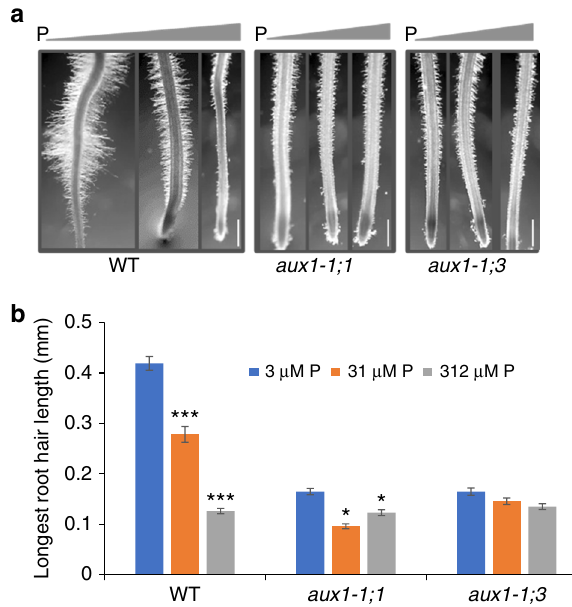
Fig. 3 OsAUX1 promotes root hair growth at low external P levels. a 9-day- old WT, os aux1-1;1 and osaux1-1;3 seedlings were grown for 6 days in hydroponics at three different P concentrations. Scale bar 1 mm. b Quantitation of RH length in WT, os aux1-1;1 and osaux1-1;3 mutants reveal low P. Each bar represents the average length of 30 – 60 fully elongated RH on >10 nodal roots. *, **, and *** indicate signi fi cant difference p value <0.05, 0.001, and 0.0001, respectively. Error bars mean ± SE, n = three biological replicates and p values were calculated by Student ’ s t